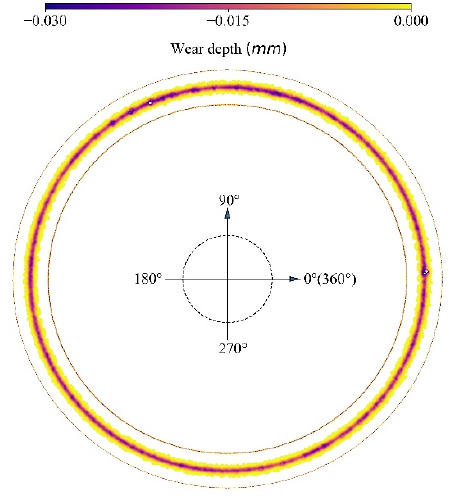
Figure 17. Wear profile.